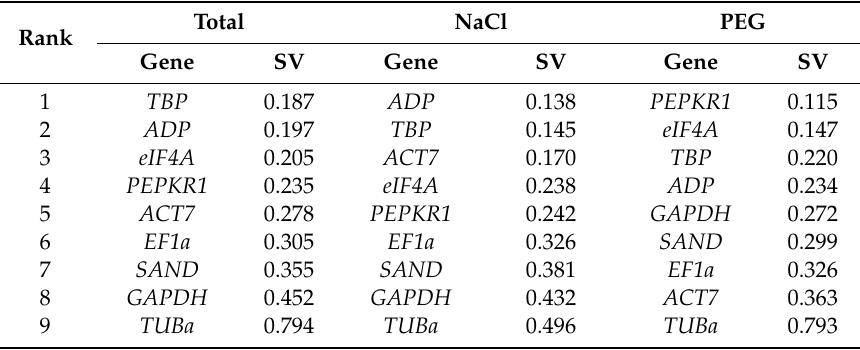
Table 1. Stability analysis of candidate reference genes performed by NormFinder algorithm. The lower the stability value (SV) the more stable is the gene’s expression in tested samples. Analysis was performed for NaCl treated samples (NaCl), PEG treated samples (PEG) and all samples combined together (Total).